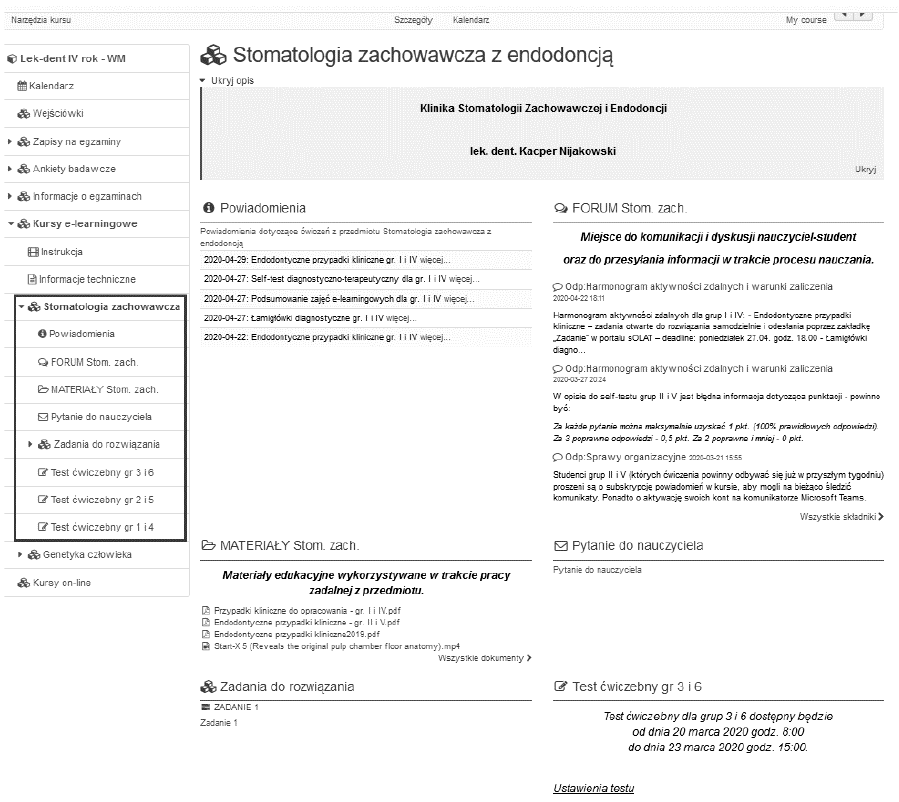
Figure 1. E-learning course in Conservative Dentistry and Endodontics for year 4 students of